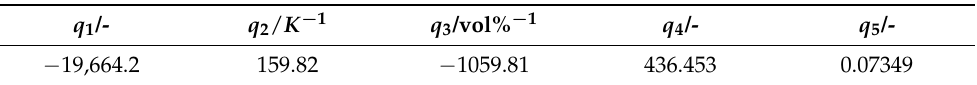
Table 3. Parameters of Equation (18) for the interpolation of NTP values. q 1